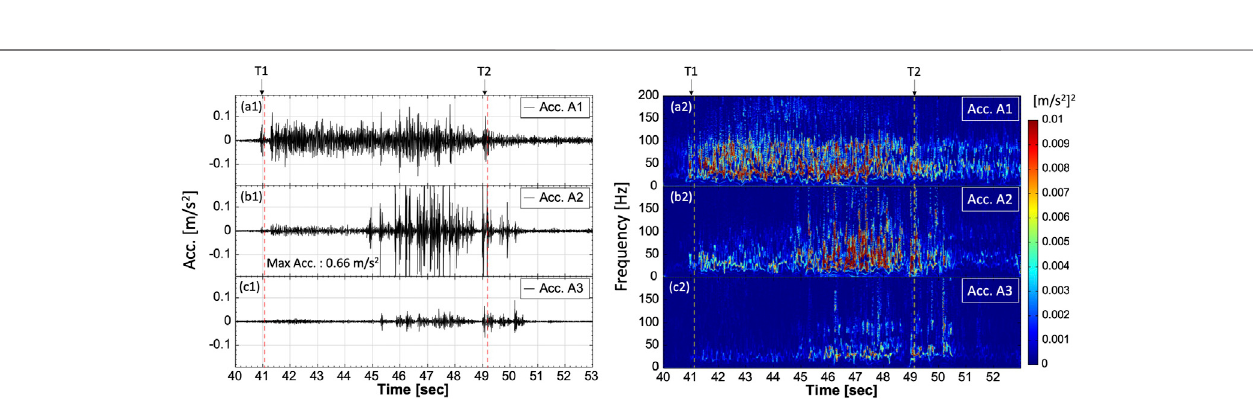
Frontiers in Earth Science |